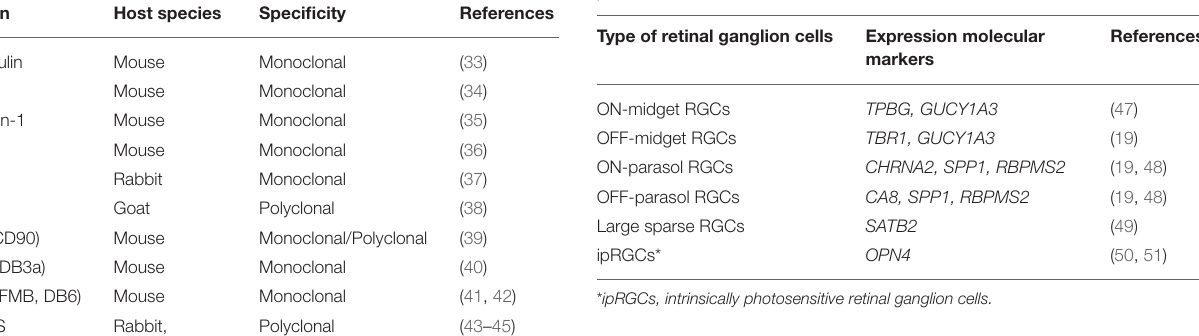
TABLE 3 | Expression molecular markers of major retinal ganglion cells in